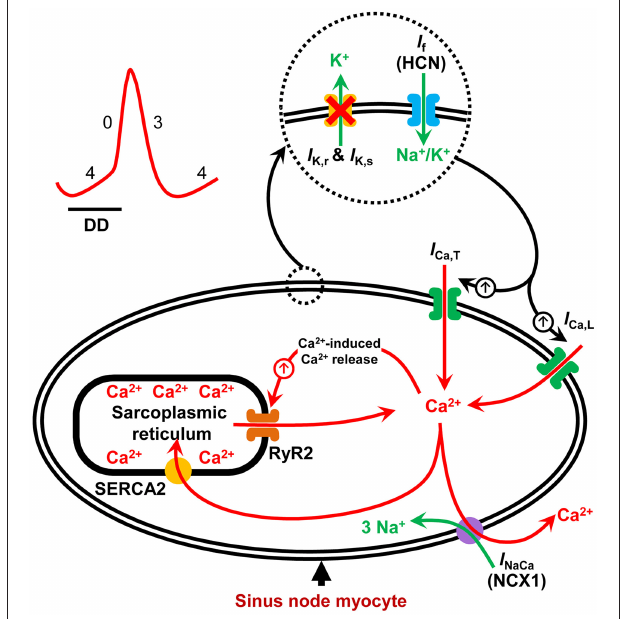
FIGURE 1 | Schematic illustration of pacemaker mechanisms in the sinus node myocyte. Sinus node action potential is preceded by a slow diastolic depolarization (DD) which brings the membrane potential up to the threshold level for excitation. The DD is a result of synergistic interaction between the membrane voltage-clock and the subcellular Ca 2 + -clock. The membrane voltage-clock comprises plasma membrane bound, voltage-dependent ion channels and their corresponding ionic currents. At the beginning of the DD, there is voltage-dependent deactivation of outward K + currents ( I K , r and I K , s ) and activation of inward currents: hyperpolarization-activated cyclic nucleotide-gated (HCN) or funny current ( I f ), T-type Ca 2 + current ( I Ca , T ) and L-type Ca 2 + current ( I Ca , L ) amongst others. The Ca 2 + -clock contributes to sinus node DD through localized Ca 2 + release from the sarcoplasmic reticulum via the ryanodine receptor (RYR2). Increased levels of cytosolic Ca 2 + activates the electrogenic Na + –Ca 2 + exchanger (NCX1) generating an inward current ( I NaCa ) that imparts a steep, exponential increase to the late phase of DD. SERCA2 refills the sarcoplasmic reticulum with Ca 2 + and is hence crucial to sinus node